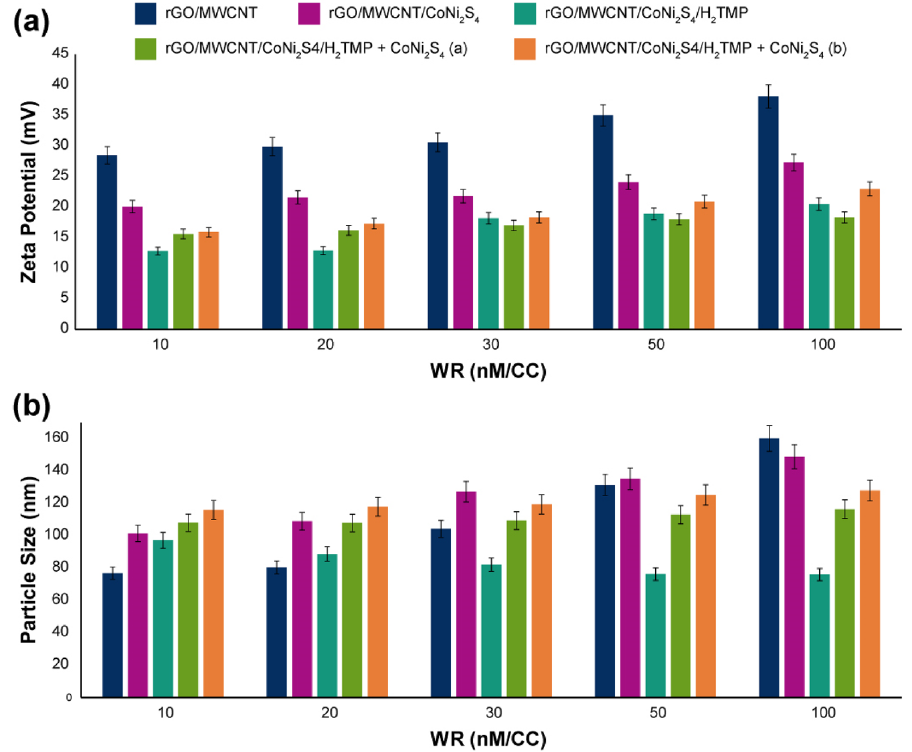
Figure 6. ( a ) The zeta potential results of the synthesized 3D nanocomposite along with each compartment of that and by addition of the excess amount of CoNi 2 S 4 (through blending with the nanocomposite) with ( a ) 10 mg mL −1 and ( b ) 20 mg mL −1 concentrations; and ( b ) the particle size results of the synthesized 3D nanocomposite along with each compartment blended with CRISPR/Cas9 of that and by addition of the excess amount of CoNi 2 S 4 (through blending with the nanocomposite) with ( a ) 10 mg mL −1 and ( b ) 20 mg Ml –1 concentrations. One point regarding the zeta potential and particle size is that they were investigated in the presence of CRISPR/Cas9 and its biological